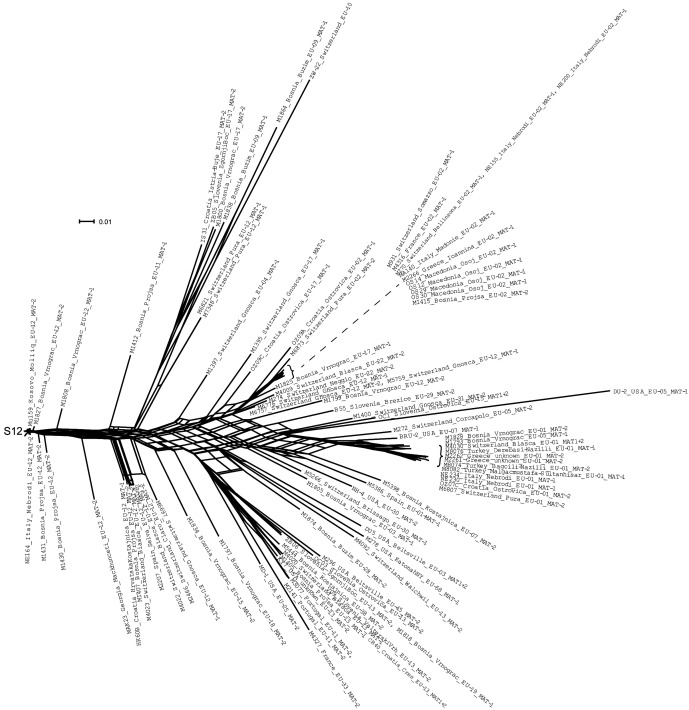
SplitsTree of all non-S12 isolates showing full isolate identifiers.Isolates identified as S12 are listed in Supplementary file 1.